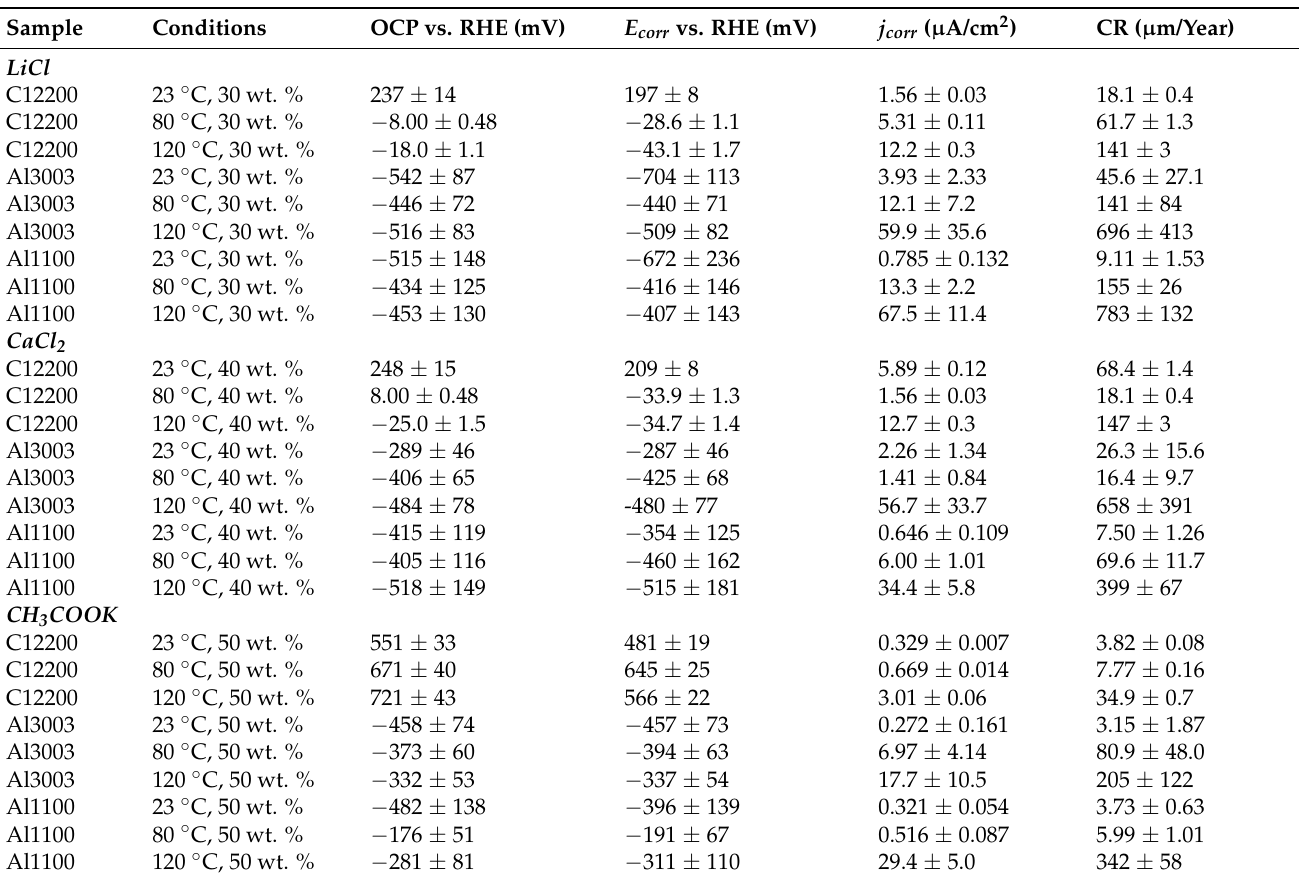
Table 2. Comparison of corrosion in different liquid desiccant solutions.